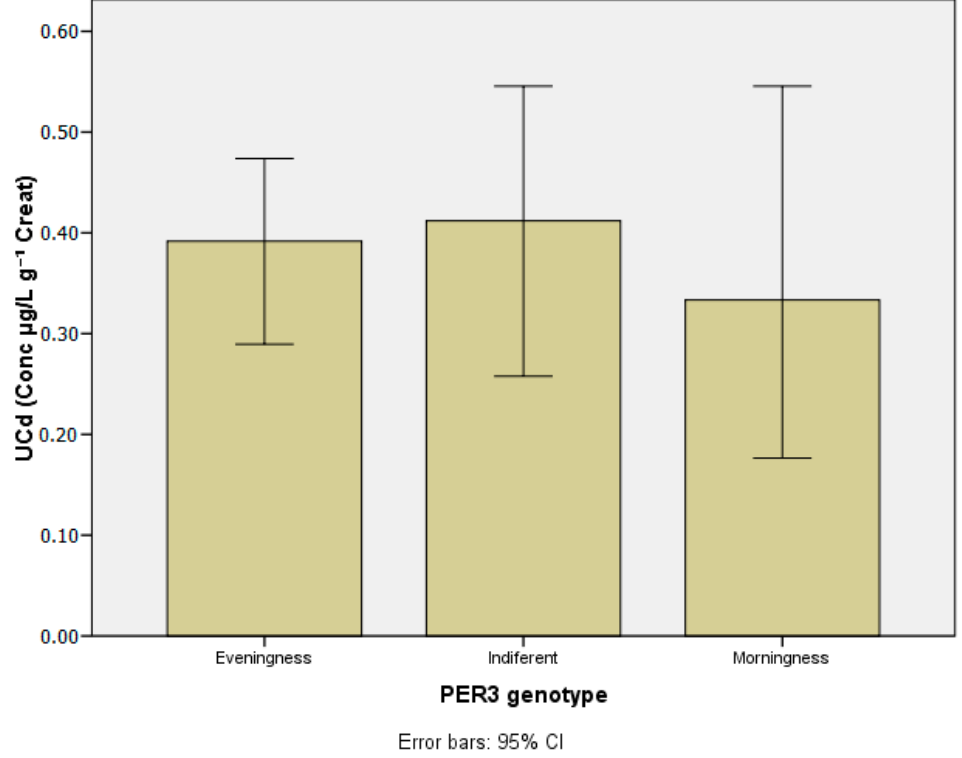
Figure 6. Cadmium in urine ( μ g g − 1 creat) according to PER3 gene VNTR polymorphisms.